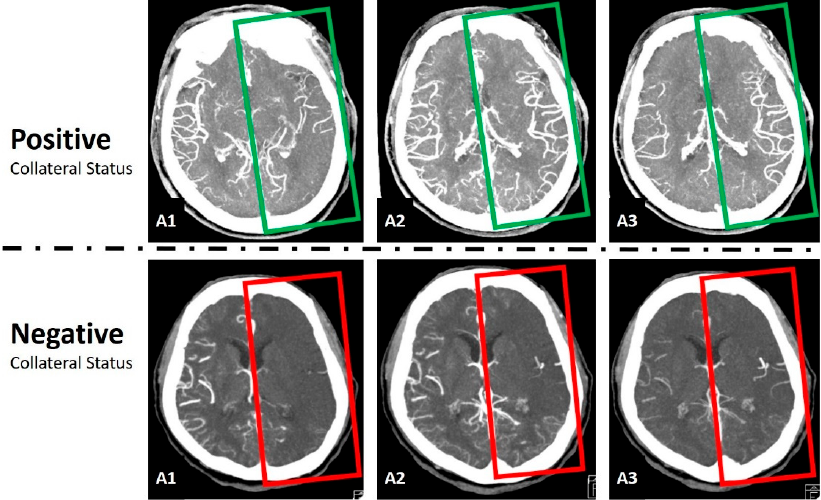
Figure 2. Demonstration of positive and negative collateral status on multiphase CTA. The A1, A2, and A3 indicate the three arterial phases. In the positive collateral status (upper row), the left side brain (green frame) is the ischemic side. When the enhancement of the arterial branches in the ischemic side can achieve similar appearance to the A1 contralateral normal side in A1 or A2 (this case), the collateral status is good or intermediate, respectively, and the result is defined as the positive collateral status. On the contrary, in the negative collateral status (lower row), the arterial branches in the ischemic side (red frame) cannot be enhanced like the A1 contralateral normal side in A1 or A2, suggesting that the collateral status is poor and the result is defined as the negative collateral status.